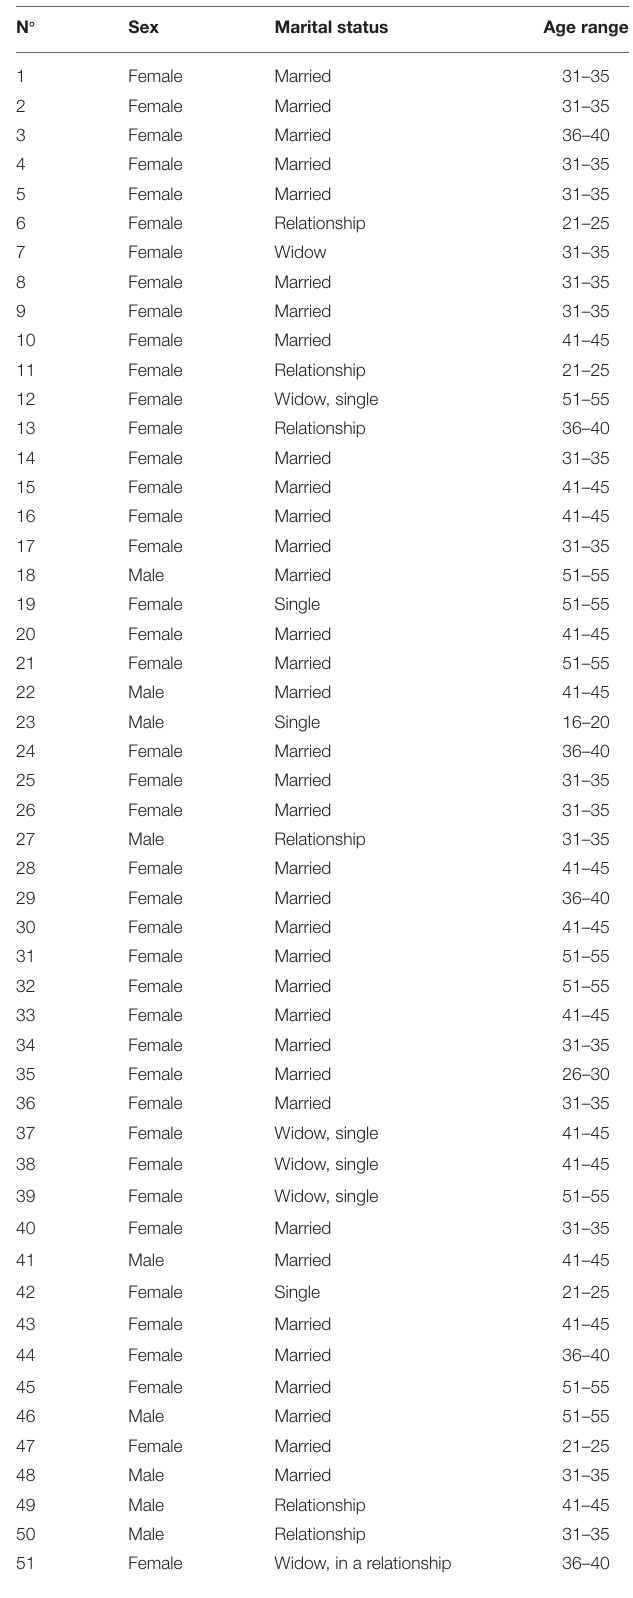
TABLE 2 | Profile of the participants with who HIVST was discussed and/or proposed during the